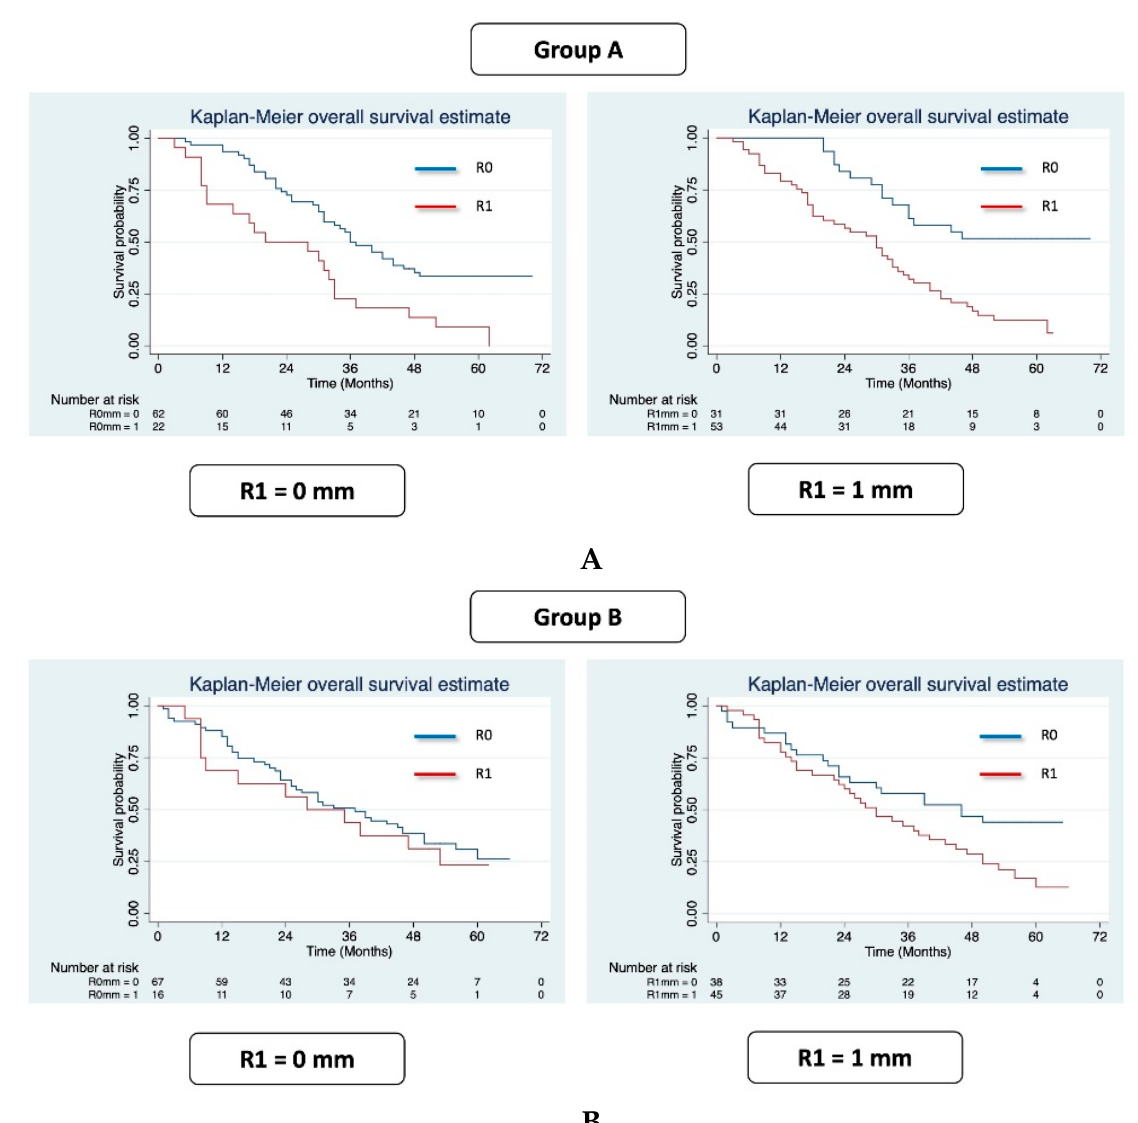
Figure 4. ( A ) Kaplan-Meier curves according to R status. OS for group A at 0 mm ( left side ) and 1 mm ( right side ) clearance. ( B ) Kaplan-Meyer curves according to R status. OS for group B at 0 mm ( left side ) and 1 mm ( right side ) clearance.